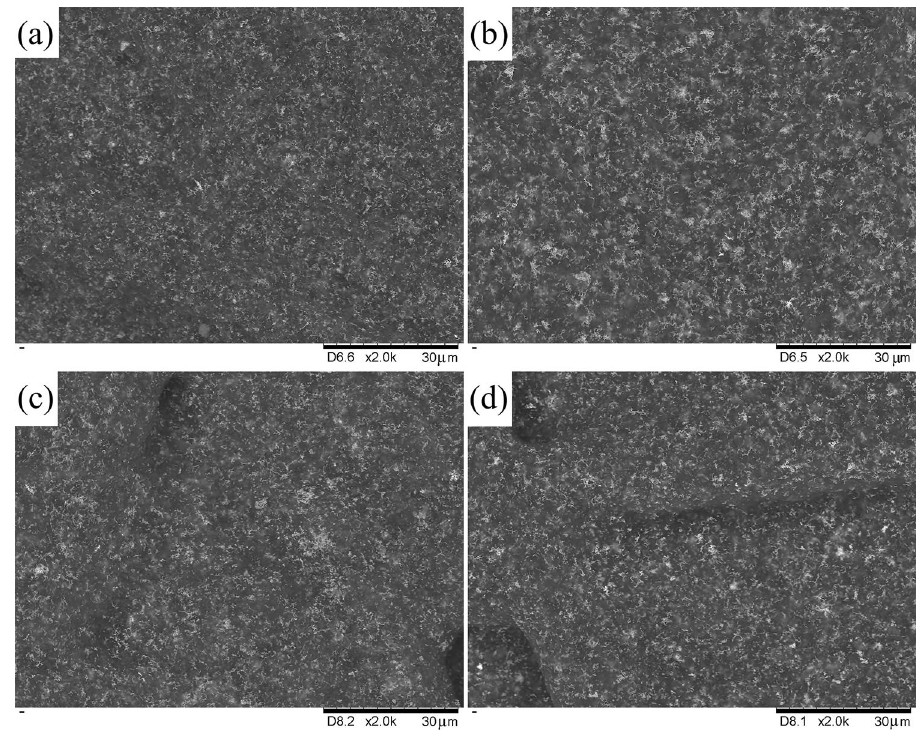
Figure 4. SEM images of top-down views of the gas diffusion electrodes with different Nafion ionomer additions (a) 3:1, (b) 5:1, (c) 7:1, (d)